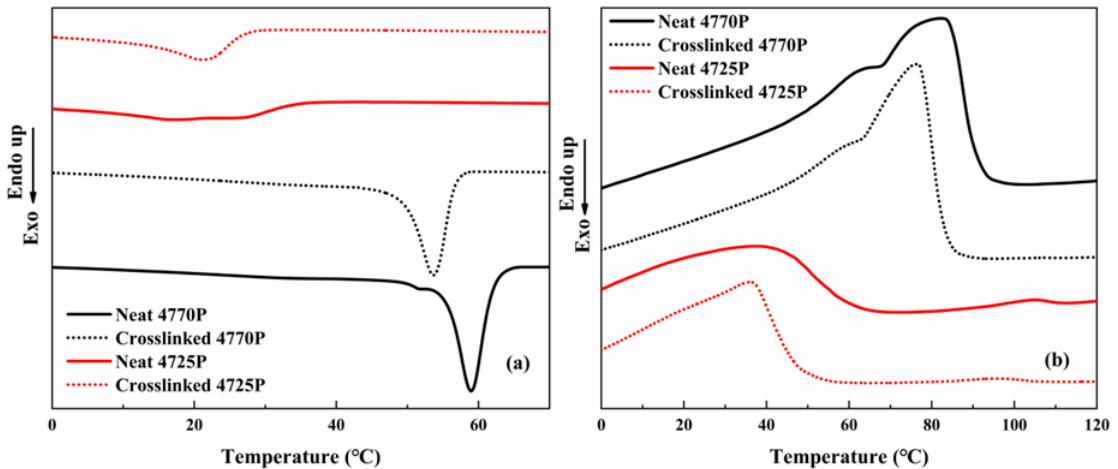
Figure 3. DSC cooling (10 °C/min) thermograms and the subsequent melting (10 °C/min) thermo- grams of neat 4770P, neat 4725P, crosslinked 4725P, and crosslinked 4770P: ( a ) cooling thermograms; ( b ) the subsequent melting thermograms.